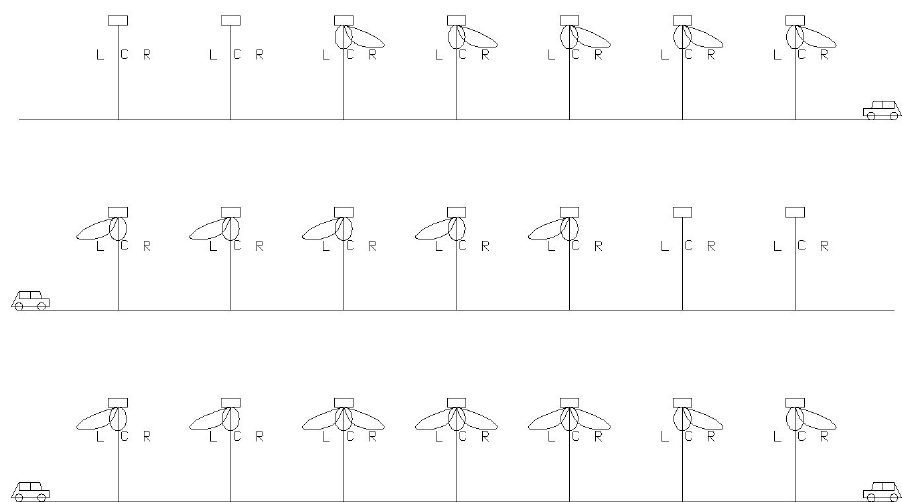
Figure 5. Depending on the direction the user is coming from, the appropriate sections in the respective luminaires light up.